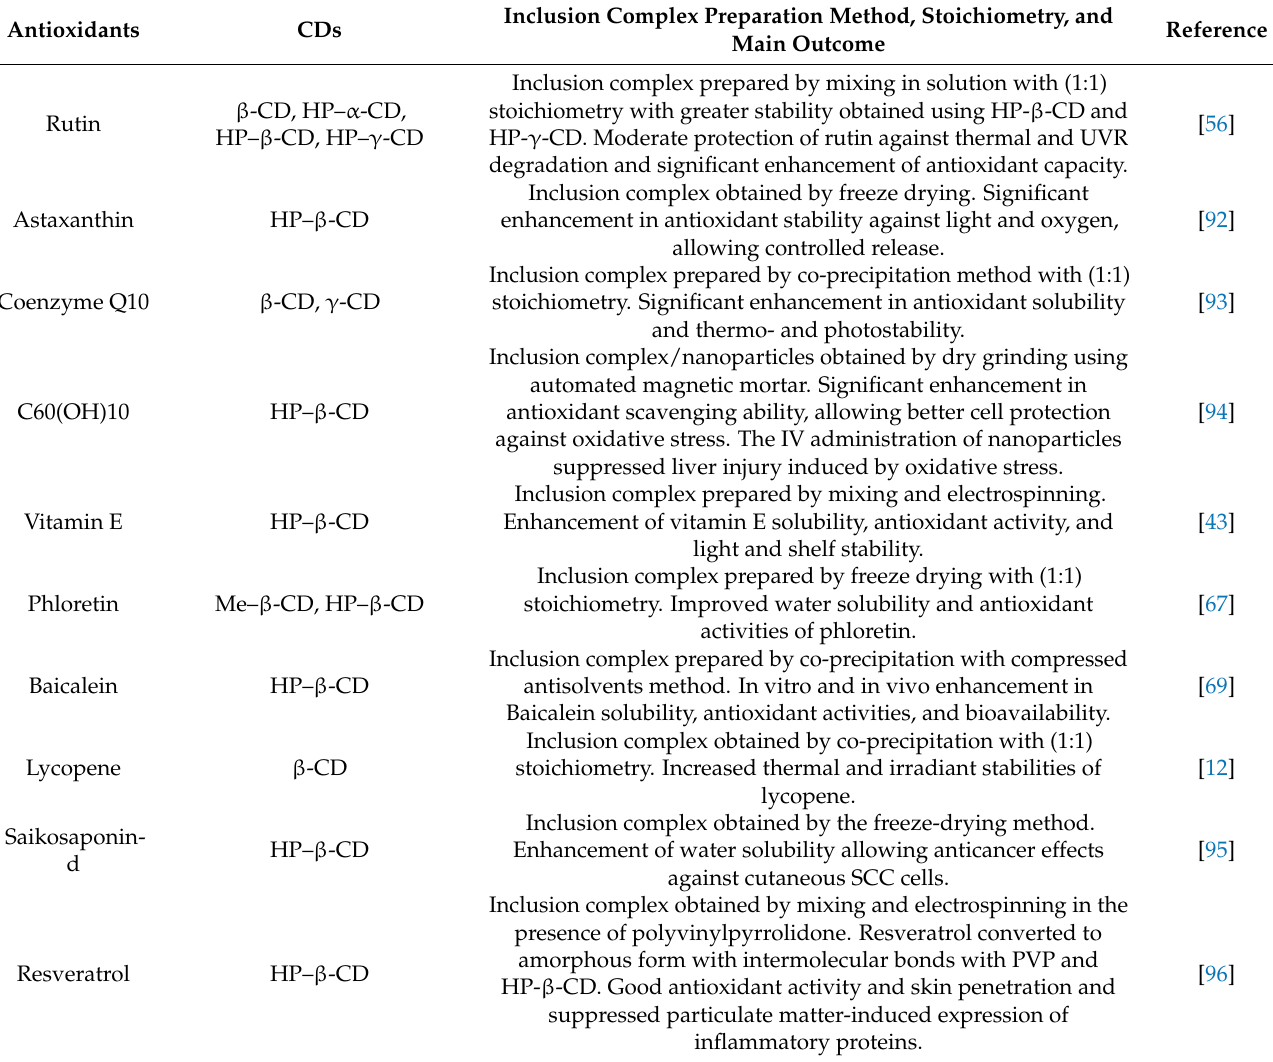
Table 2. Summary of outcomes of antioxidant–CD inclusion complexes in reviewed studies. Inclusion Complex Preparation Method, Stoichiometry, and Antioxidants CDs Main